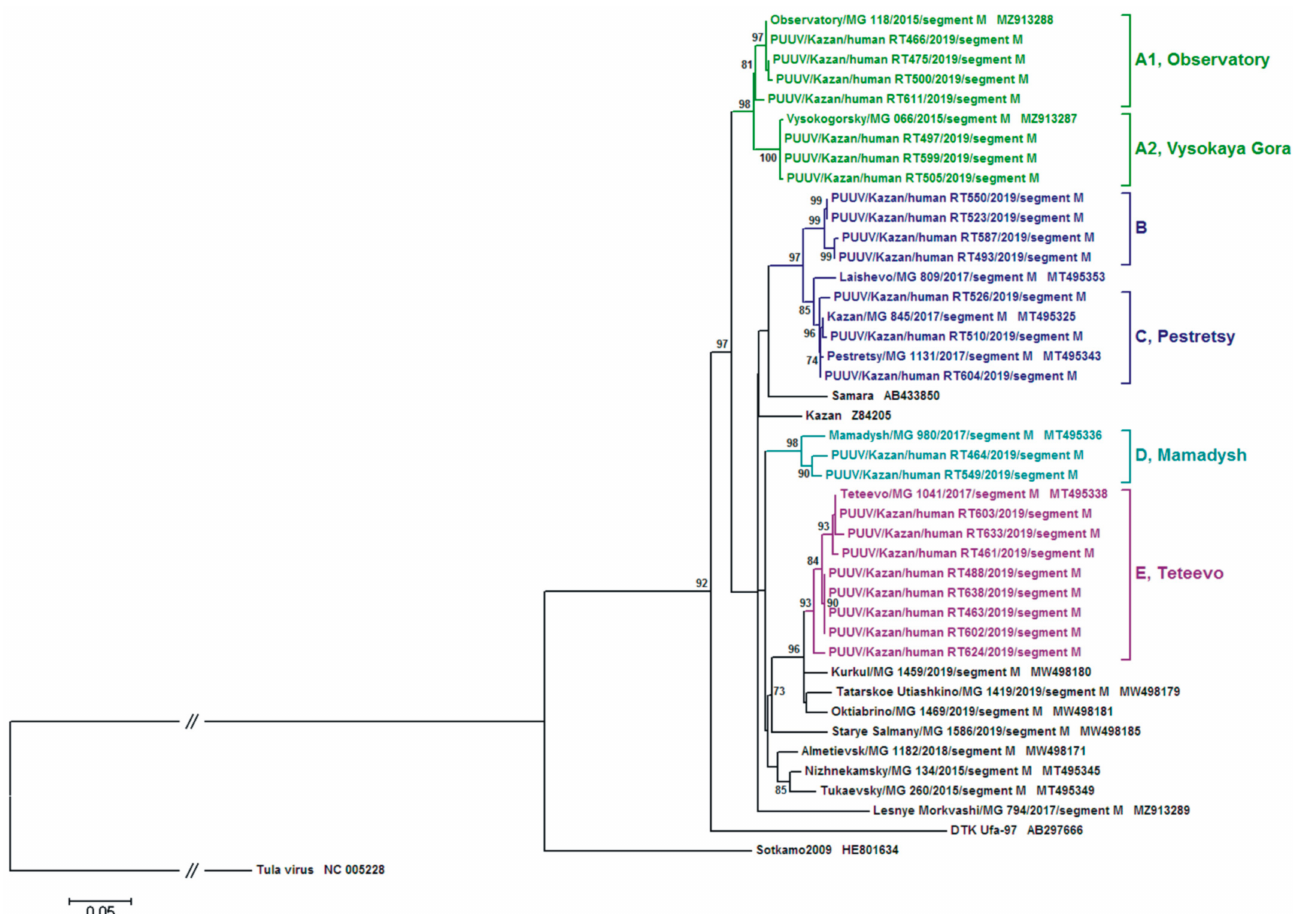
Figure 4. The phylogenetic tree based on the M segment partial nt sequences of Puumala ortho- hantavirus from hemorrhagic fever with renal syndrome patients and bank voles. The percentage of trees in which the associated taxa clustered together is shown next to the branches. For clarity, only taxa percentages above 70 are shown on the tree. Initial tree(s) for the heuristic search were obtained by applying the Neighbor-Joining method to a matrix of pairwise distances estimated using the Maximum Composite Likelihood (MCL) approach with 1000 bootstrap replicates. A discrete Gamma distribution was used to model evolutionary rate differences among sites (five categories (+ G , parameter = 0.7671)). The rate variation model allowed for some sites to be evolutionarily invariable ([+ I ], 39.8943% sites). The tree is drawn to scale, with branch lengths measured in the number of substitutions per